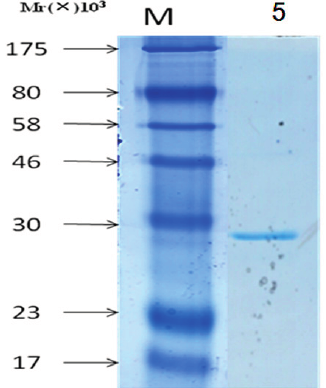
Figure 5. Purified protein Apyrase was identified by SDS-PAGE. Line M: molecular weight marker: 175 kDa, 80 kDa, 58 kDa, 46 kDa, 30 kDa, 23 kDa and 17 kDa; Line A: the purified protein